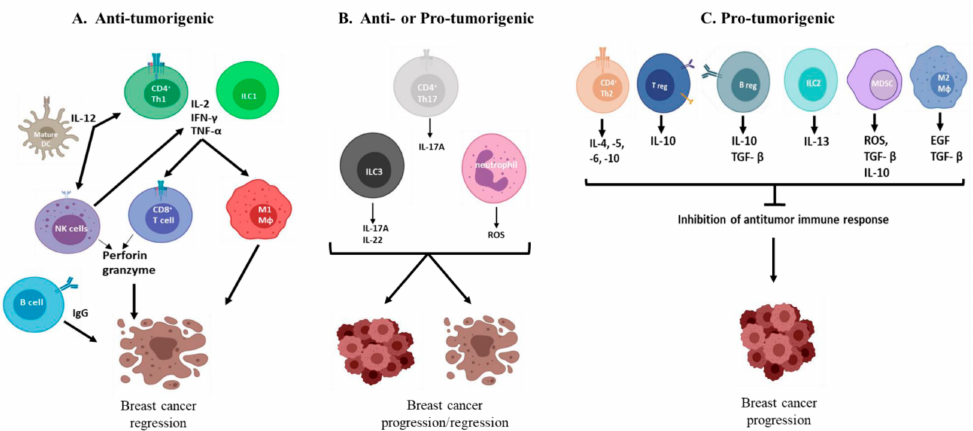
Figure 1. The role of di ff erent immune cells in breast cancer. Panel A shows anti-tumorigenic immune cells. Mature dendritic cells (DCs) present antigens to T cells and secrete IL-12 which enhances anti-tumorigenic CD4 + Th1 and natural Killer (NK) cell immune responses. CD4 + Th1 and ILC1 secrete IL-2, IFN- γ and TNF- α which stimulate anti-breast tumor immune activity by activating e ff ector cells such as cytotoxic T cells (CD8 + T cells) and M1 macrophages (M ϕ ). NK cells also secrete IFN- γ and TNF- α . CD8 + T cells and NK cells secrete perforin and granzyme which directly kill breast cancer cells while B cells secrete IgG which has anti-tumor activity. Panel B shows immune cells that possess both anti- and pro-tumorigenic activities. CD4 + Th17 cells and ILC3s produce IL-17A which has been shown to be both anti- and pro-tumorigenic in breast cancer. ILC3s also secrete IL-22 which has been reported to reduce breast cancer growth. Neutrophils can suppress CD8 + T cell function and secrete reactive oxygen species (ROS) which kill breast cancer cells. Panel C shows pro-tumorigenic immune cells. CD4 + Th2 secrete IL-4,-5,-6 and -10 while ILC2s secrete IL-13. Regulatory T (Treg) and B (Breg) cells secrete IL-10 and TGF- β which suppress anti-tumor immune responses. M2 macrophages and myeloid derived suppressor cells (MDSCS) also secrete the TGF- β and other factors which dampen anti-tumor immune responses and stimulates tumor growth. IL (interleukin), Th1 (type 1 T-helper cells), ILC1 (group 1 innate lymphoid cells), IFN- γ (interferon-gamma), TNF- α (tumor necrosis factor-alpha), M1 macrophages (classically activated macrophages) IgG (immunoglobulin G), Th17 (type 17 T-helper cells ), ILC3 (group 3 innate lymphoid cells), Th2 (type 2 T-helper cells), ILC2 (group 2 innate lymphoid cells), TGF- β (transforming growth factor-beta). M2 macrophages (alternatively activated